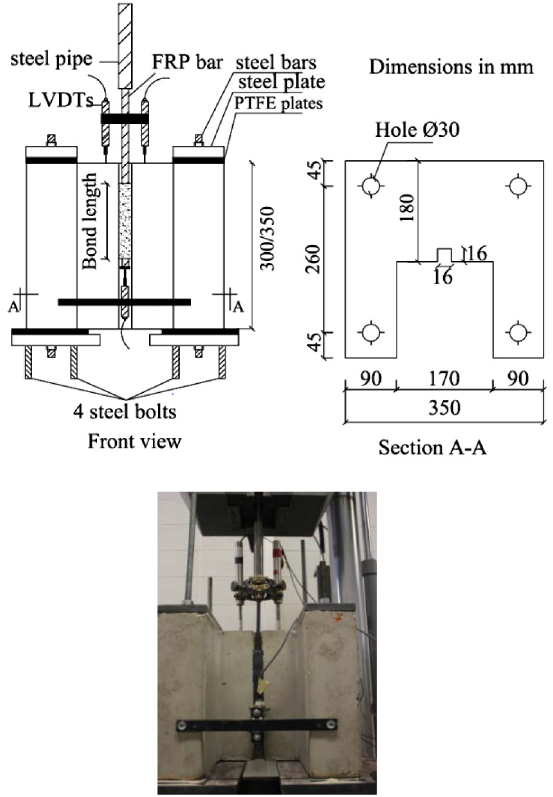
Fig. 1. Test specimen, test setup and